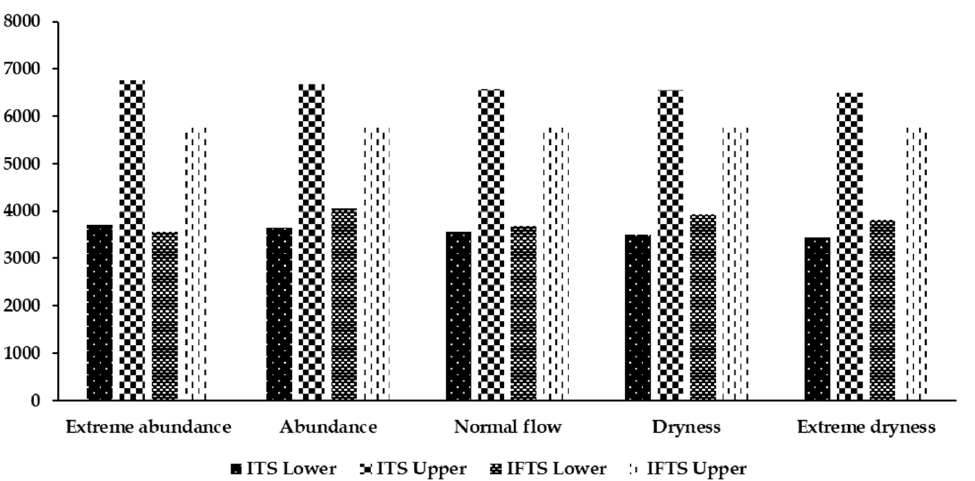
Figure 5. Comparison of the economic effect due to the interval value optimization using the ITS model and the IFTS model (×10 8 CNY).